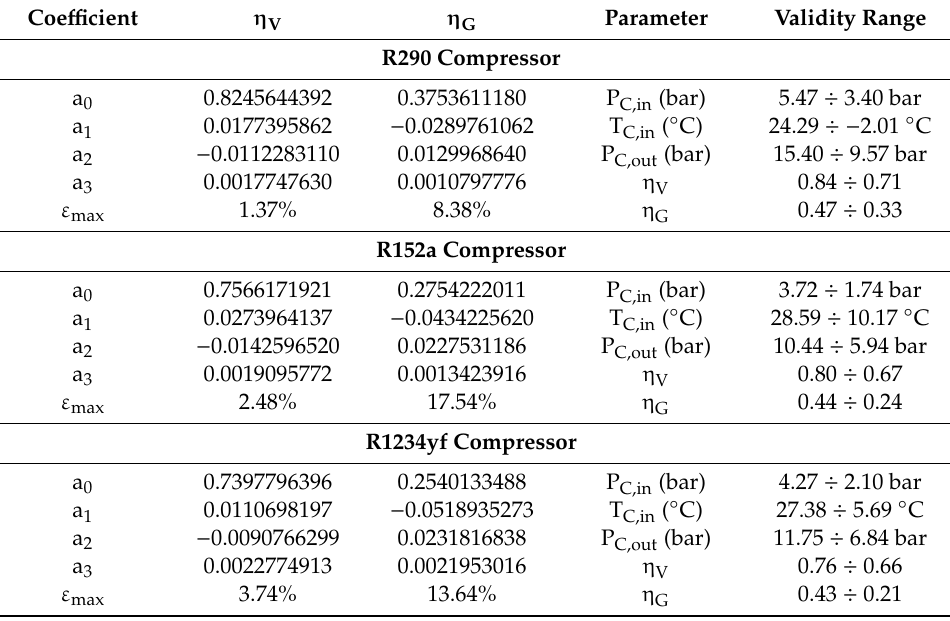
Table 9. Experimental coe ffi cients for the hermetic